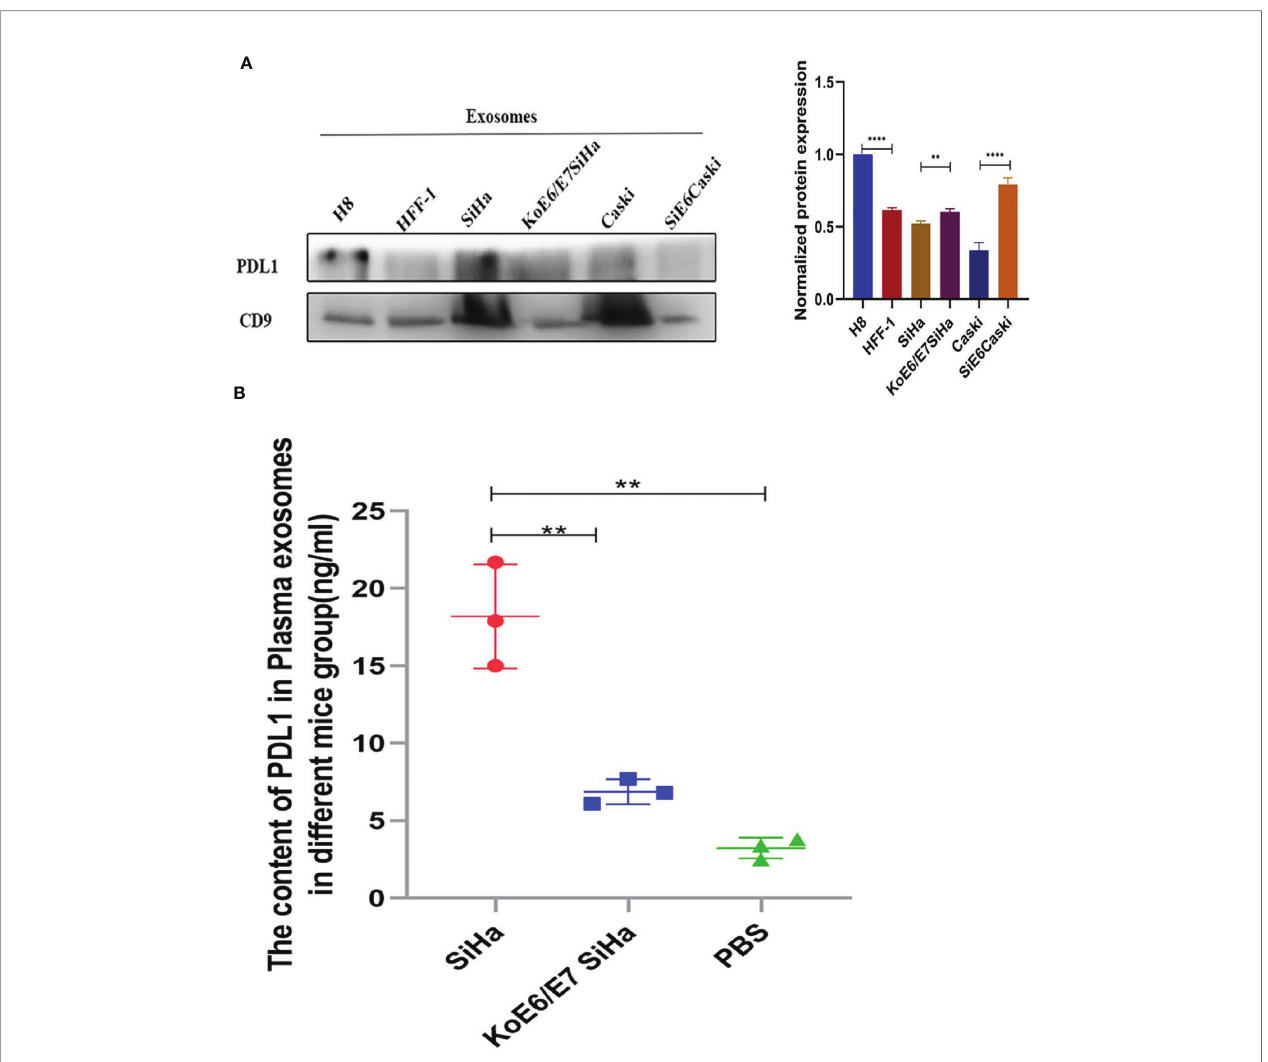
FIGURE 5 | Expression levels of PD-L1 in the NC, SiHa and KoE6/E7 SiHa groups. (A) Western blotting showed that PD-L1 was present in cell exosomes; (B) ELISA revealed that the expression levels of exosomal PD-L1 was higher in the SiHa subcutaneous tumor group than that in KoE6/E7 SiHa, which were obtained by approximately 1 ml blood collected from the heart of mice from per mouse. *P < 0.05, **P < 0.01, ***P < 0.001 and ****P < 0.0001, as determined by Student ’ s